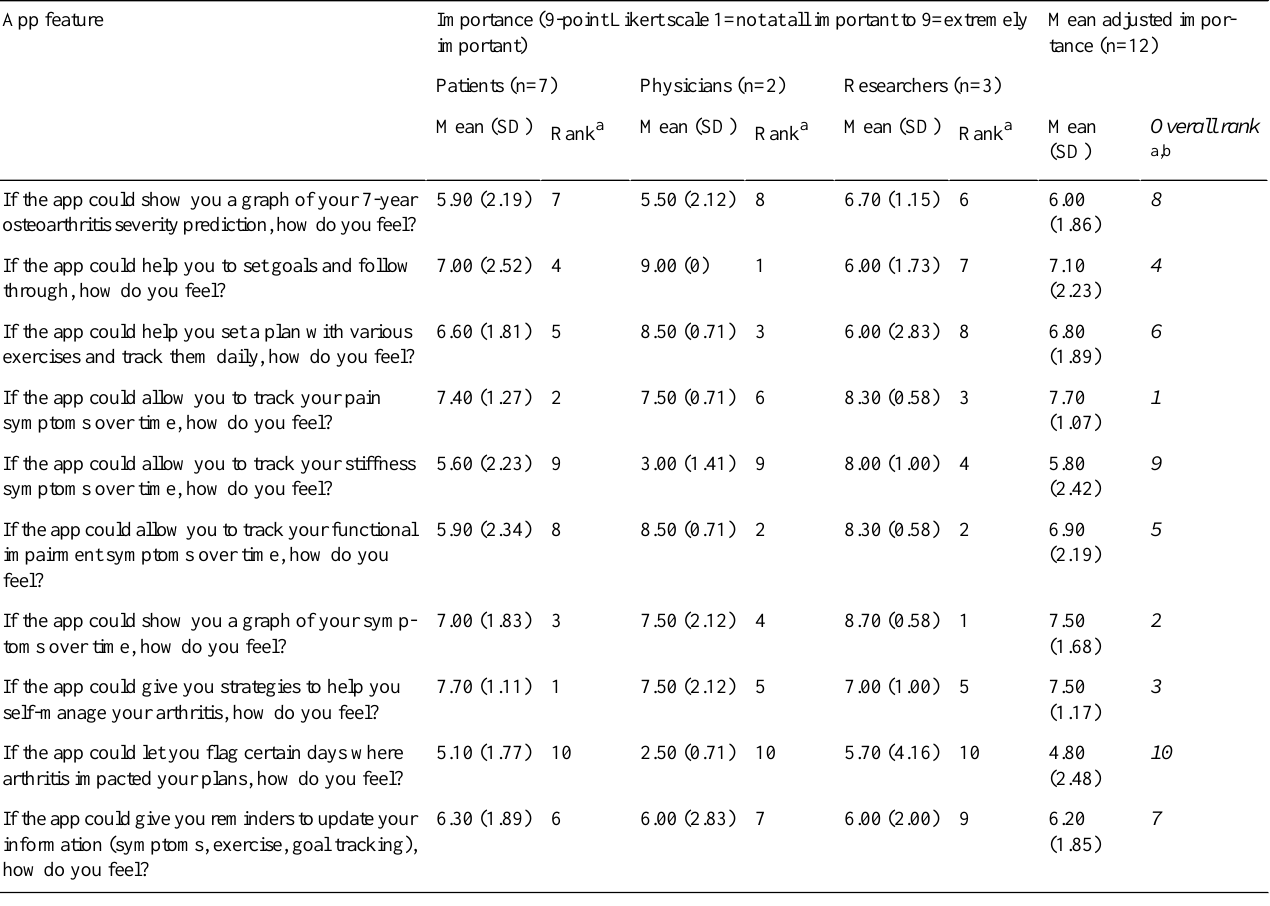
Table 4. Postsession Kano survey: importance by participant group (n=12).